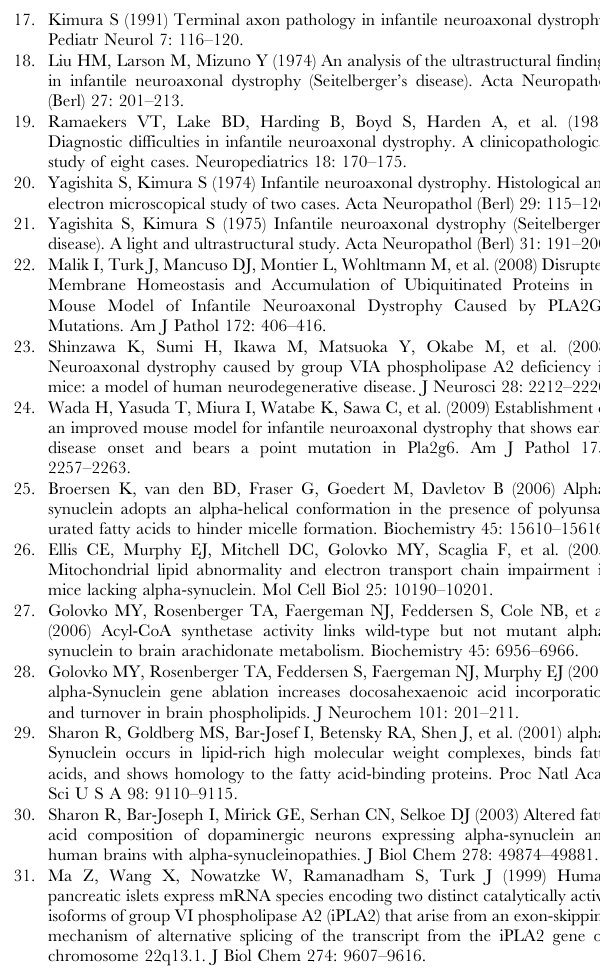
Figure S1 PLA2G6 mutations associated with dystonia-parkin- sonism do not impair PLA2G6 thioesterase activity. WT or mutant proteins were added at equal enzyme concentrations to catalytic assays utilizing radiolabeled palmitoyl CoA as substrate. Relative rates of fatty acid release are shown for WT and each mutant protein (mean percent WT + standard deviation, n= 3 independently prepared protein preparations for each of WT and 3 mutants). The asterisk indicates that the mean activity of R632W was significantly different from WT (p , 0.05, unpaired t-test). Similar to the results observed in phospholipase and lysopho- spholipase assays, mutations associated with dystonia-parkinson- ism do not impair the thioesterase catalytic activity of PLA2G6. Figure S2 Western blot analysis of purified recombinant protein to normalize WT and mutant protein concentrations in catalytic assays. The graph shows the western blot ECL signal measured for different amounts of purified WT PLA2G6 protein (diluted 15, n =3 lanes for each volume). The graph also shows a standard curve (y = 16400x-1184) obtained by linear regression (R2= 0.92) for the relationship between luminescence (after subtracting